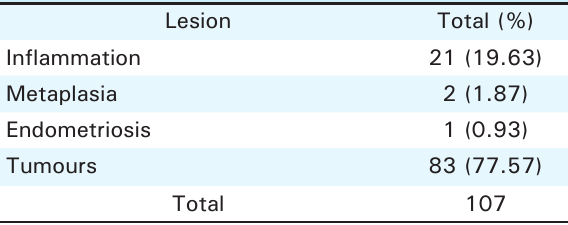
Table 2. Frequency of different pathological lesions.